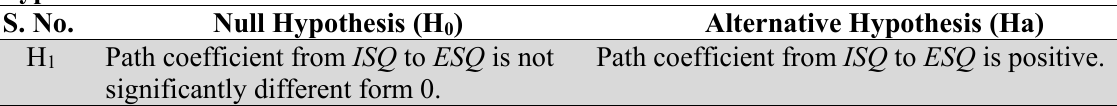
ESQ scale: Factors underlying